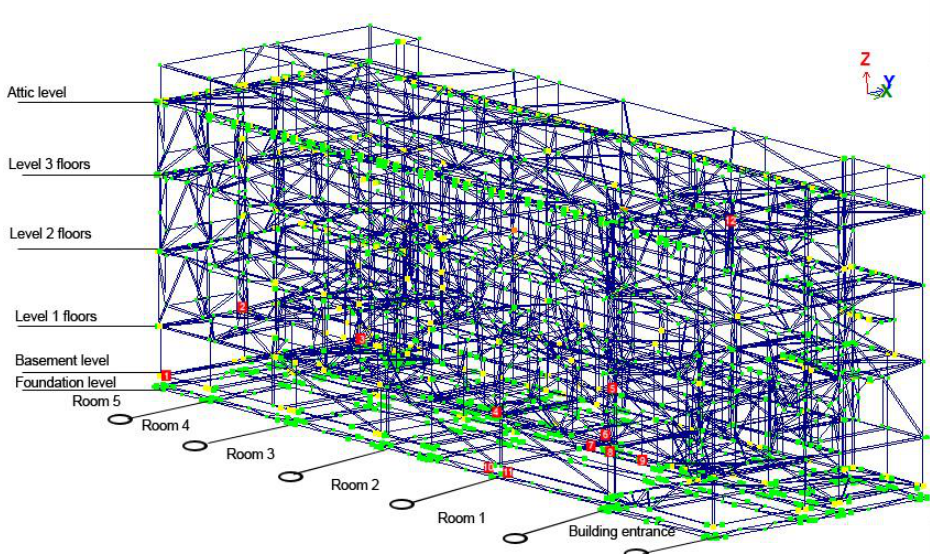
Figure 5. The most vulnerable key points with the development of hidden destructive processes.